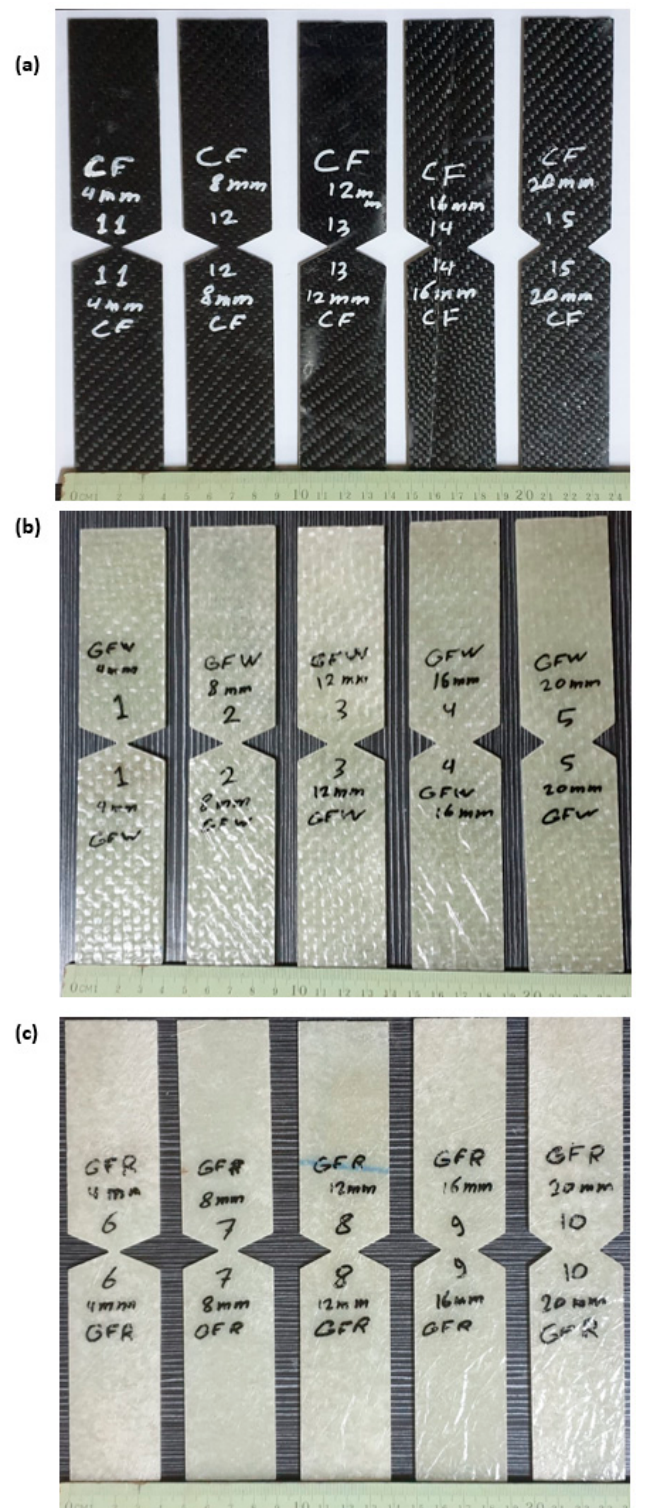
Figure 7. Ideal image of EWF specimens ( a ) CFRP (s1), ( b ) GFRP-w (s2) and ( c ) GFRP-W(s3).